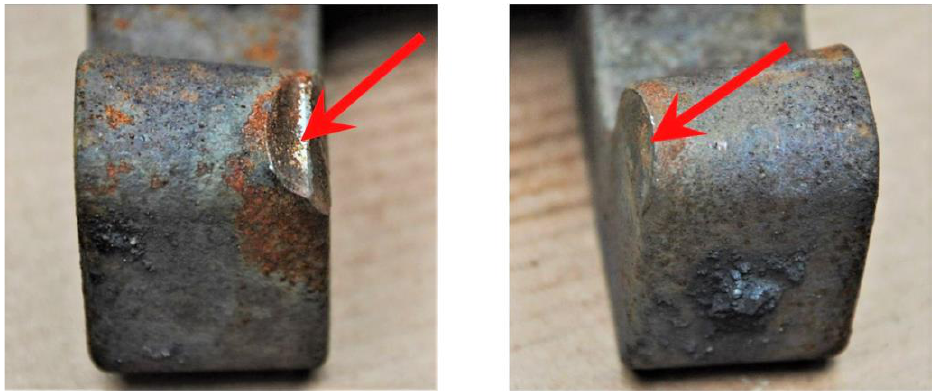
Figure 12. Damages of keeps of the Komtrack toothed segment, (marked with red arrows).